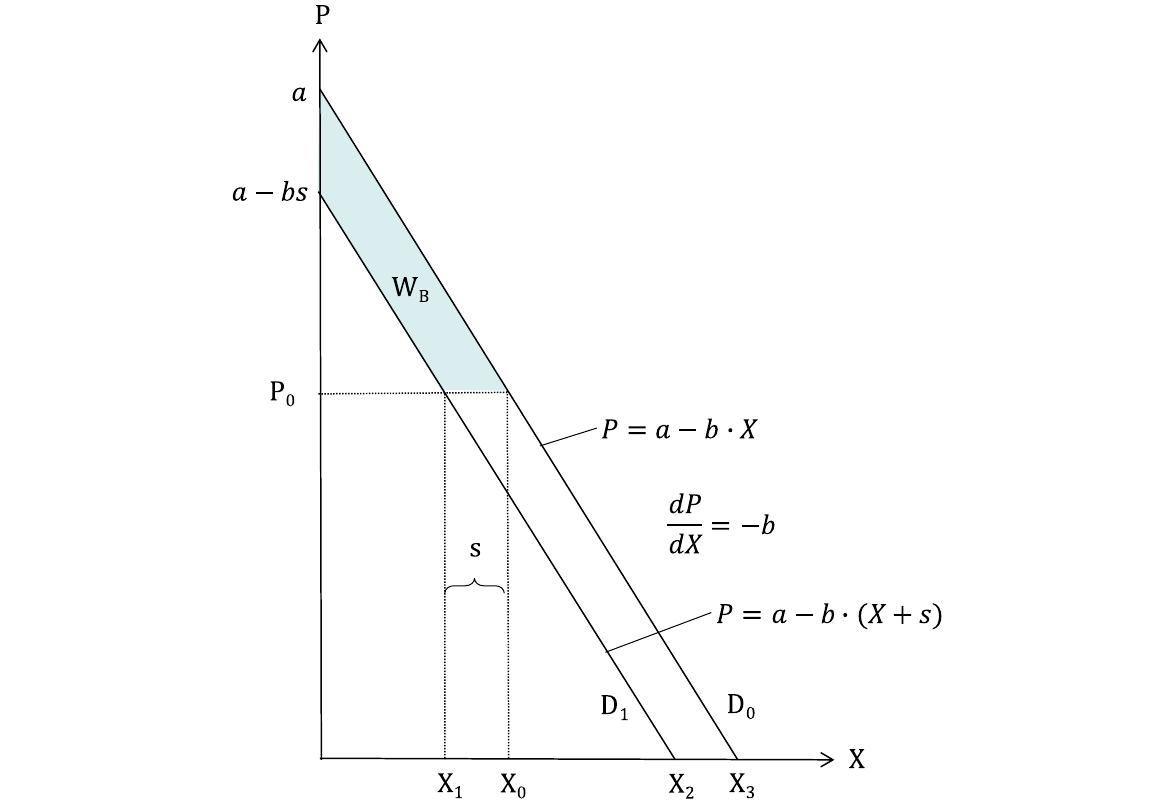
Fig. 2 Welfare consequences for the population at place B because of a change from a fixed stop to a request